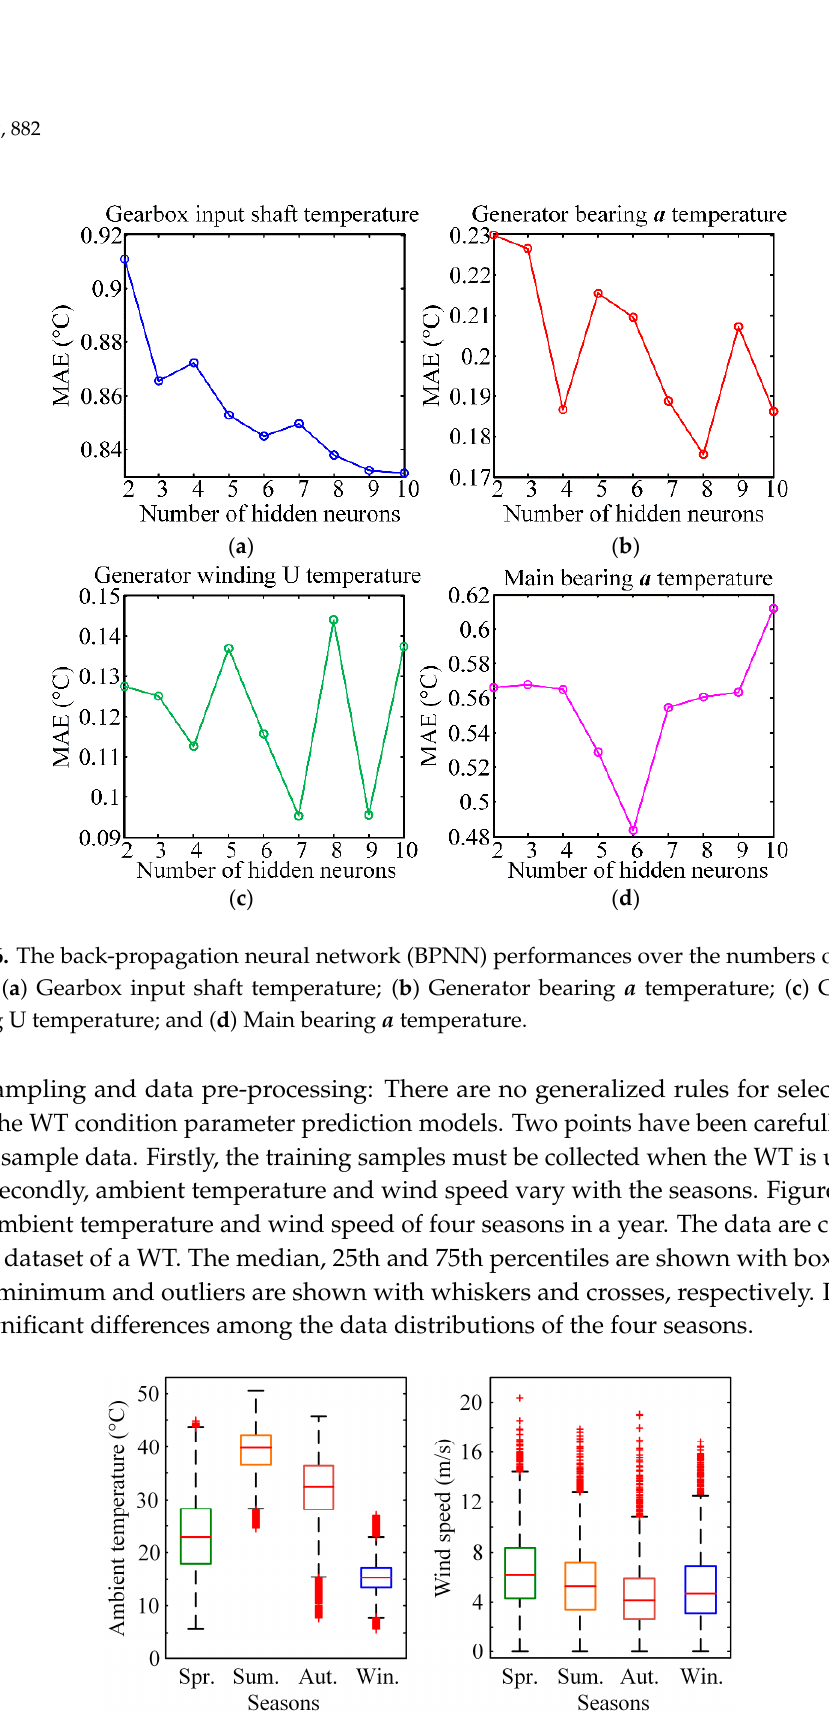
Figure 7. Boxplot of ambient temperature and wind speed of four seasons.